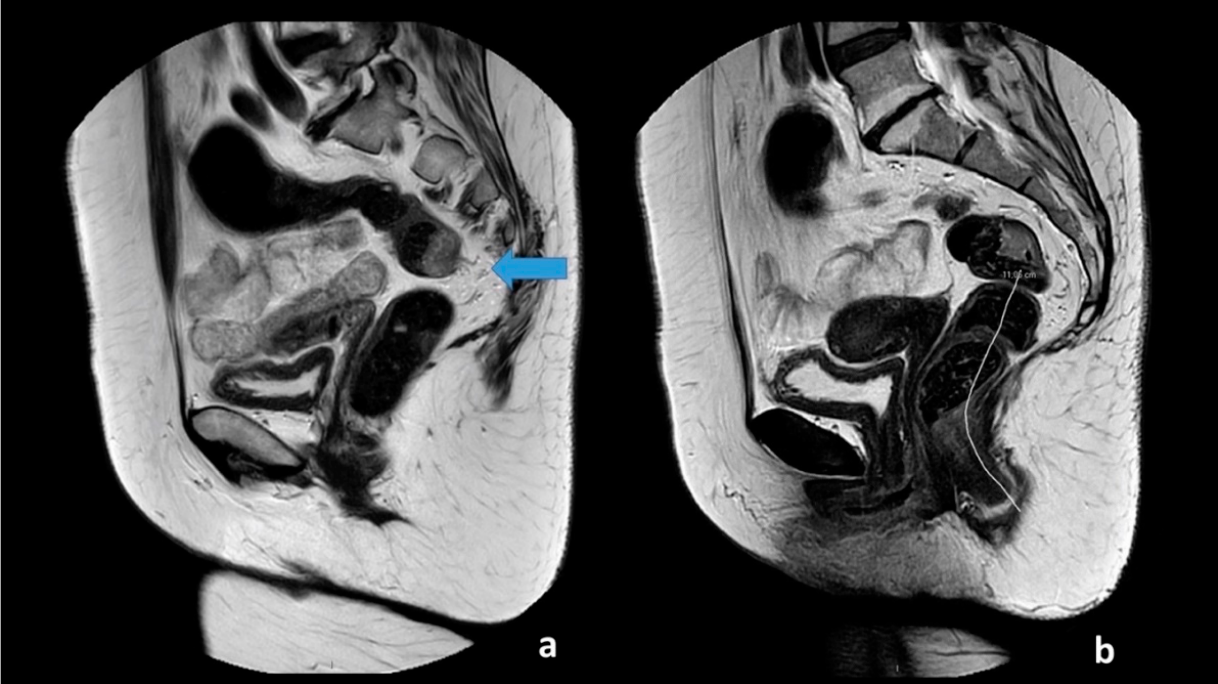
Figure 1. Sagittal T2-weighted images from a 65-year-old female patient with a T1 tumor located at the posterior wall just above the sigmoid takeoff. The arrow indicates the sigmoid take-off from which the sigmoid sweeps horizontally away from the sacrum and with the sigmoid blood vessels insertion ( a ). The takeoff and the lower border of the tumor is located 11 cm above the anal verge ( b ).